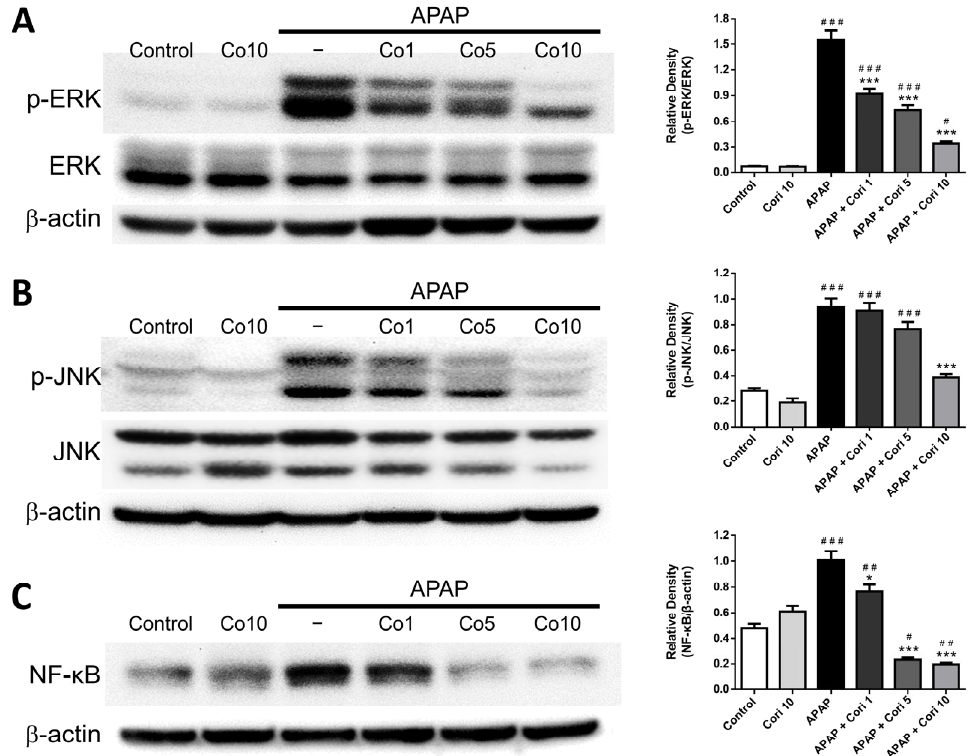
Figure 8. The effects of corilagin on ERK (A), JNK (B), and NF ‐ kB (C) expression . Animals were injected with APAP (300 mg/kg) or equal volume of saline (control), and administered with corilagin (0, 1, 5, or 10 g/kg). # p < 0.05, ## p < 0.01, ### p < 0.005 vs. control group; * p < 0.05, *** p < 0.005 vs. APAP